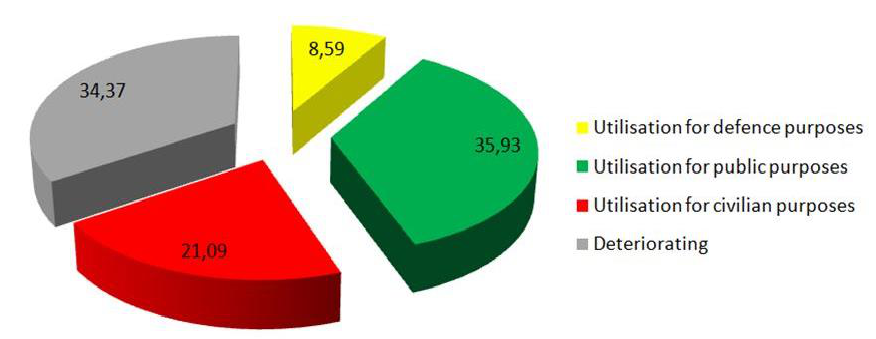
Fig. 3. Utilization of abandoned garrisons outside Budapest (Source: own survey,